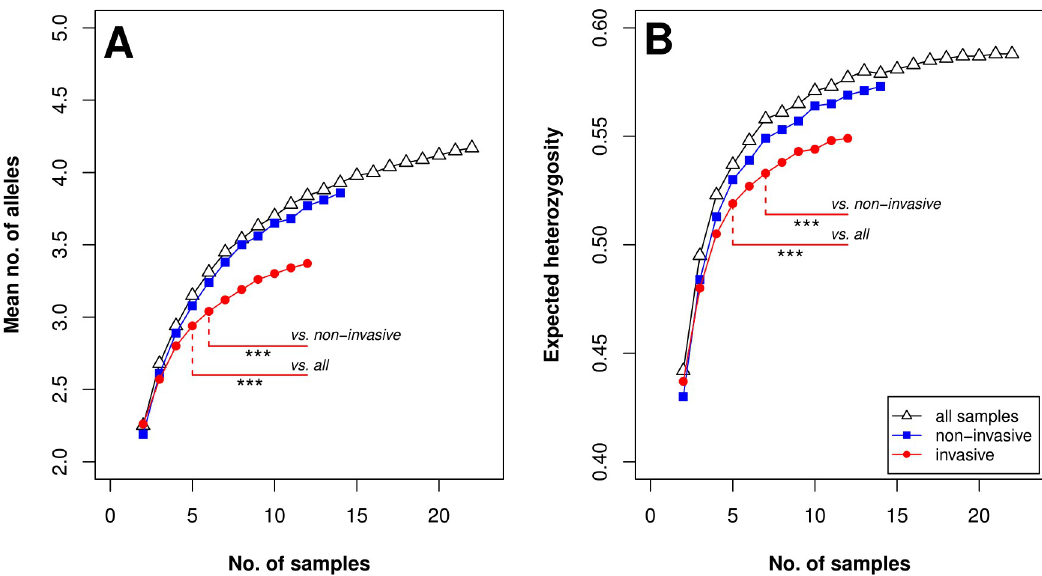
Fig 4. Accumulation rates of diversity measures with increasing sample numbers per sample type. A) Mean numbers of alleles ( N ), and B) expected heterozygosity ( H E ) values for genotypes sampled non-invasively (N = 14), invasively (N = 12) and for all genotypes (N = 22), using 8 microsatellite loci.